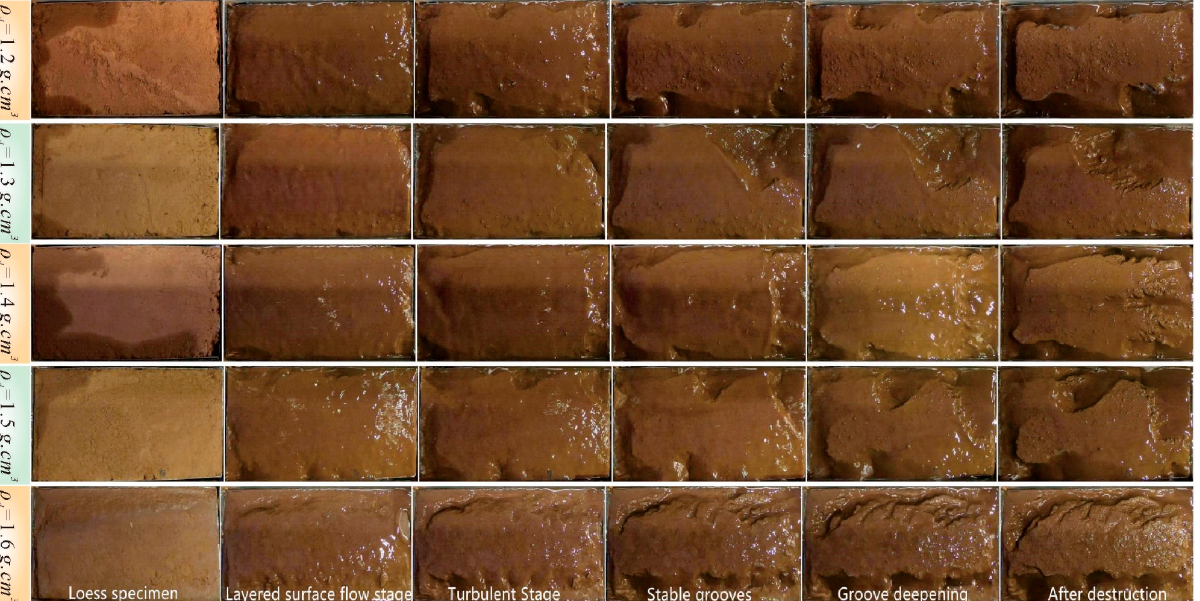
Water 2022 , 14 , x FOR PEER REVIEW Figure 3. The erosion process for different initial cross-sections of flow. Figure 3. The erosion process for different initial cross-sections of flow.